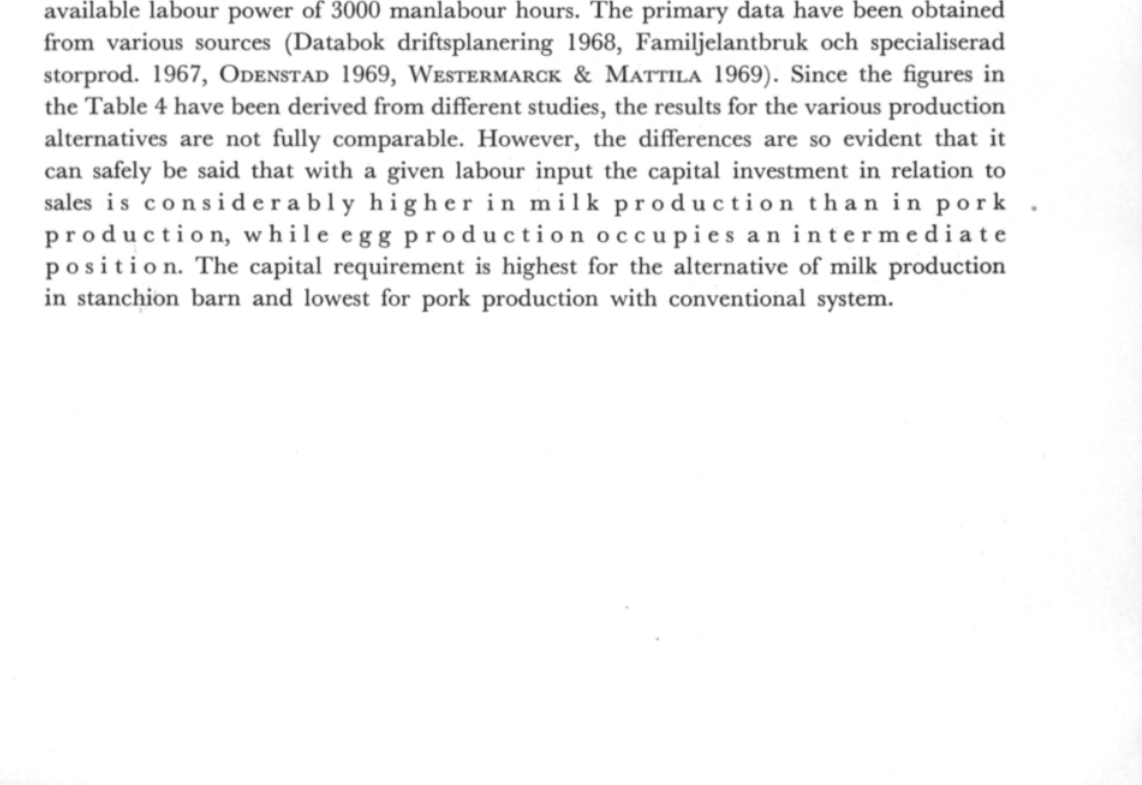
Table 4. Initial capital requirement for investment in relation to sales on a family farm with 3000 man- labour hours available per